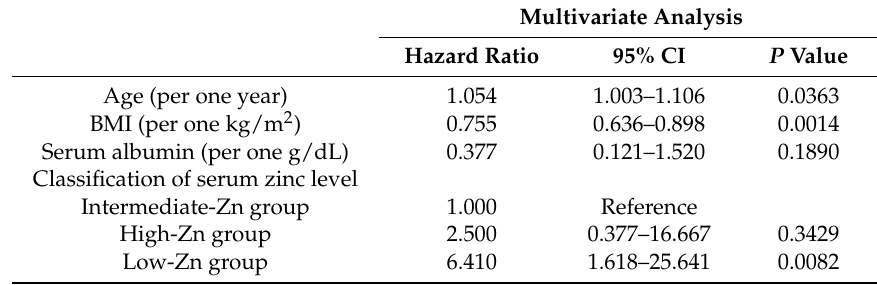
Table 5. Multivariate analyses of factors linked to the presence of sarcopenia for LC cases. Multivariate Analysis Hazard